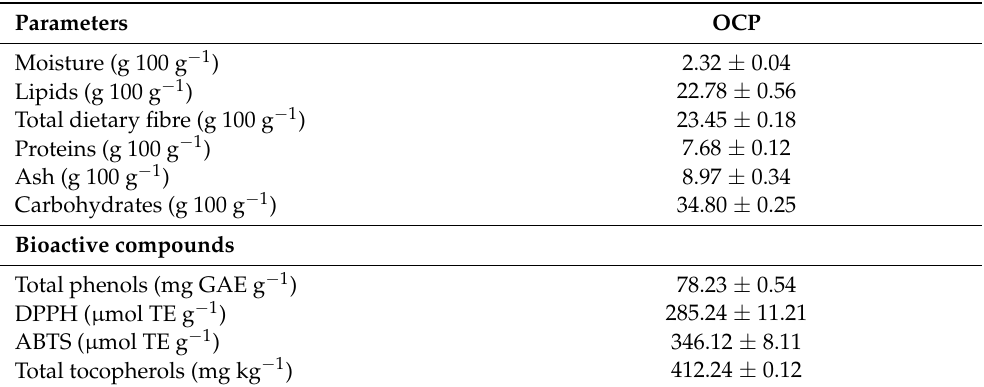
Table 1. Mean values and standard deviation of the proximate composition and bioactive profile of olive cake powder.